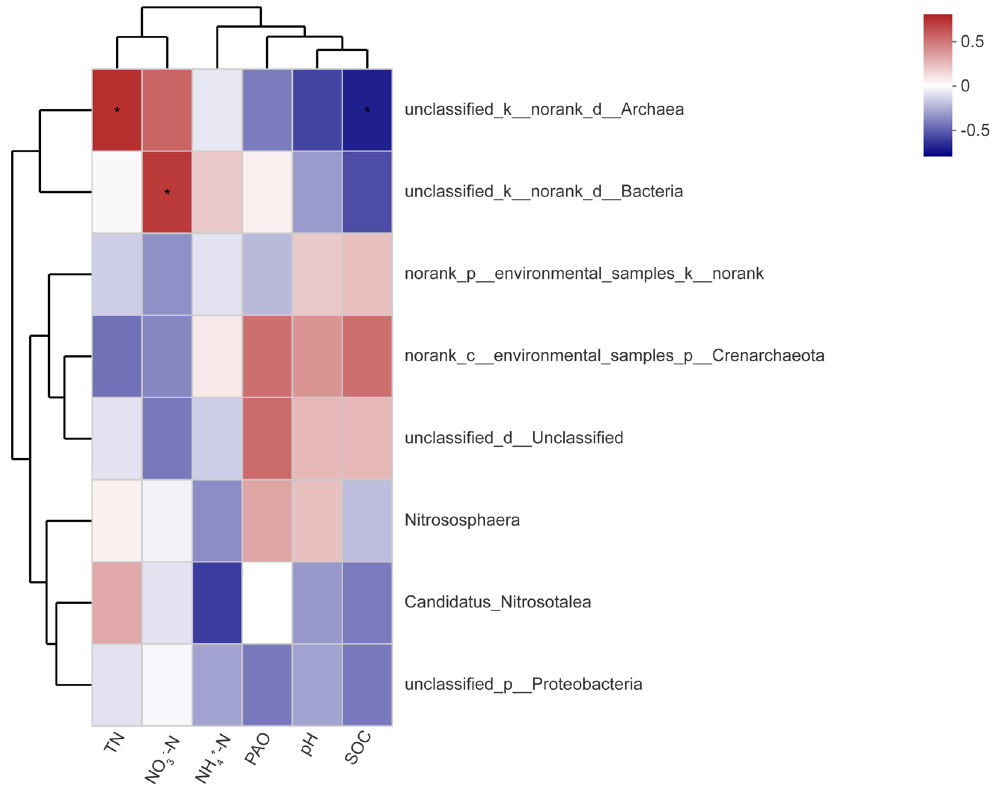
Figure 8. Correlation heatmap of edaphic characteristics and relative genus abundances of ammonia-oxidizing archaea (AOA). The color intensity expresses the correlative values of edaphic characteristics with relative genus abundances. * P < 0.05. Notes : T 0 = Traditional irrigation; T 1 = Traditional irrigation and fertilization practice;